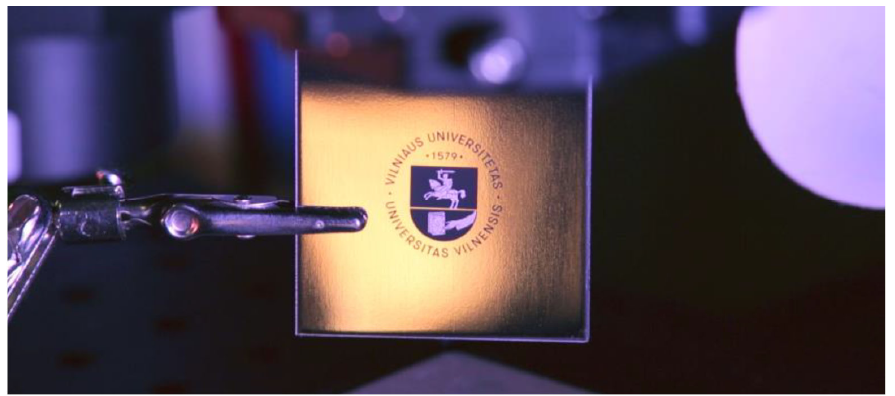
Figure 5. Vilnius University logo marked with the presented high ‐ contrast marking method.